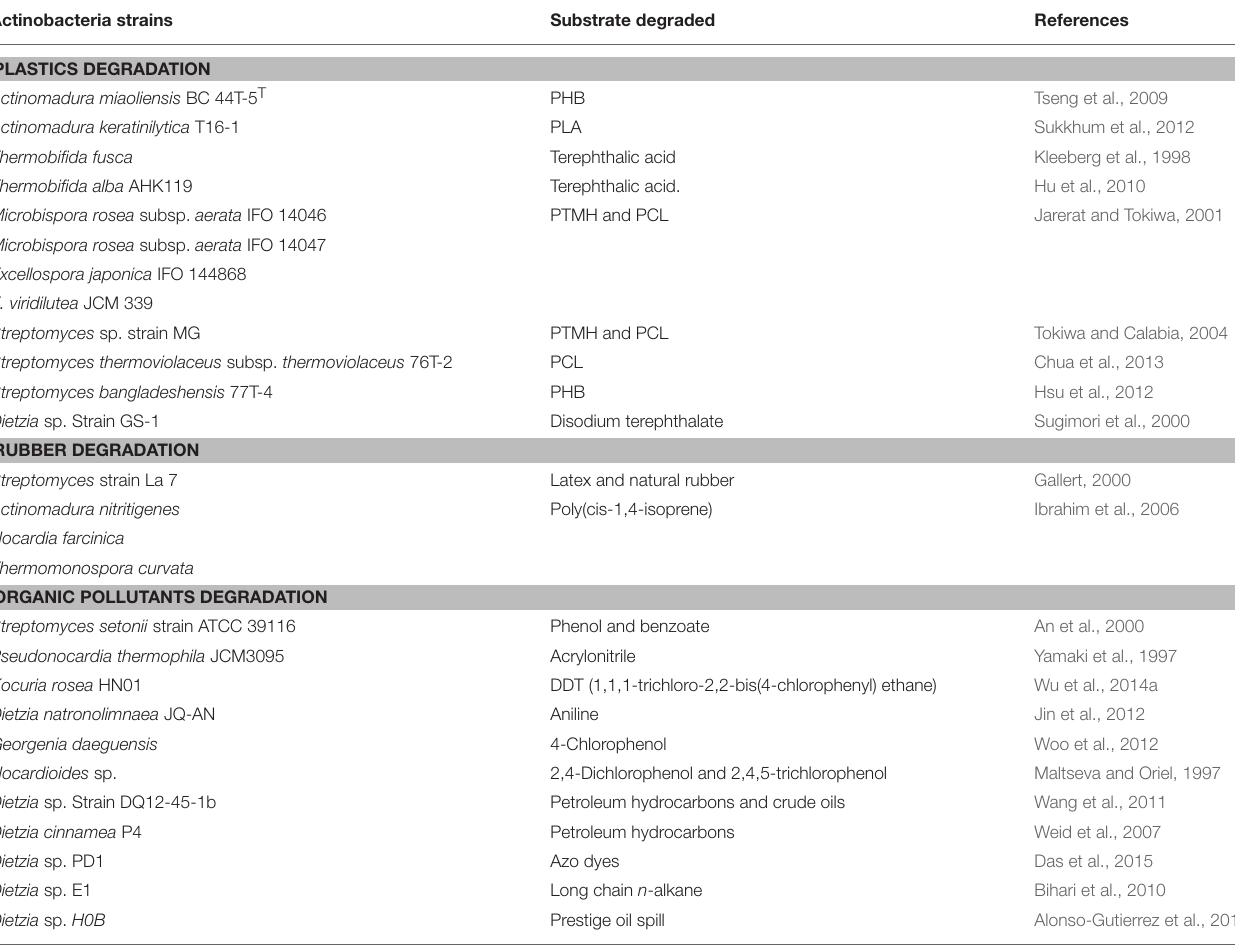
TABLE 2 | List of thermophilic and alkaliphilic actinobacteria degrading plastics, rubber and organic pollutants. Actinobacteria